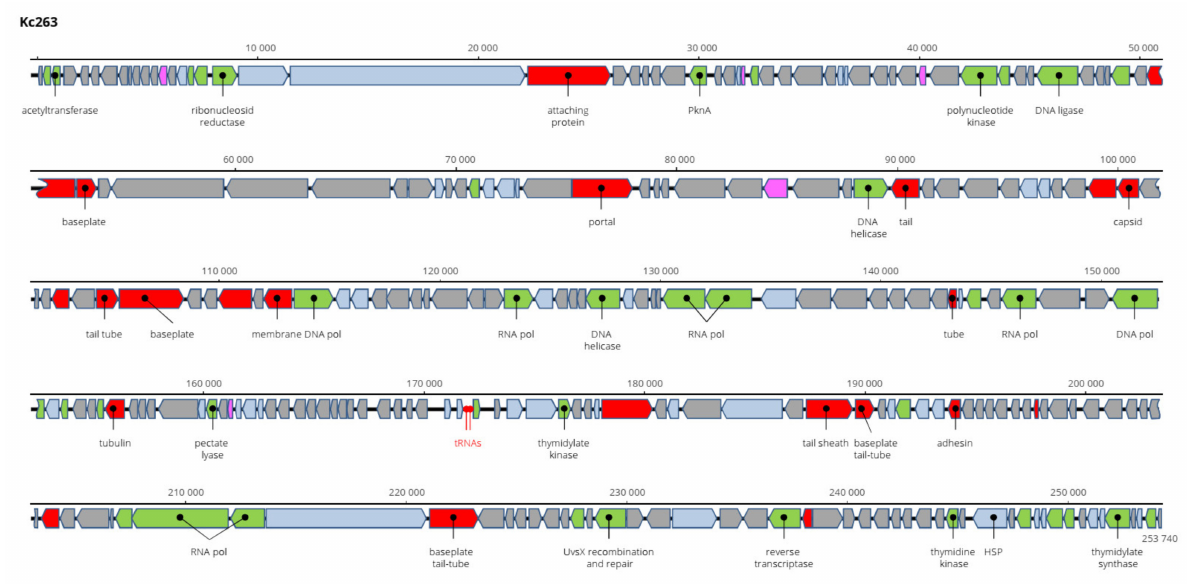
Figure 11. Genome structure and annotation of the Kc263